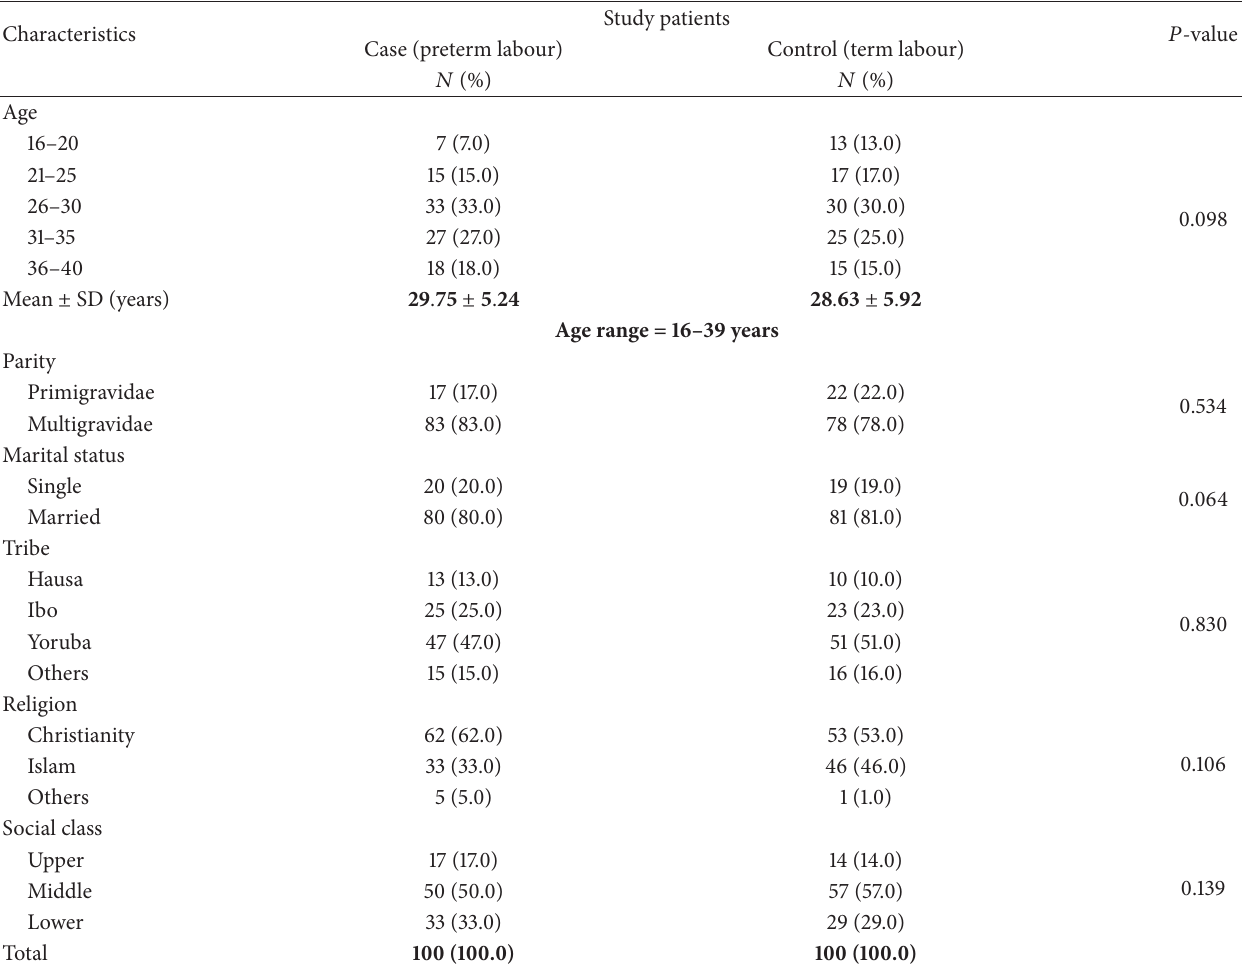
Table 2: Demographic characteristics of respondents.